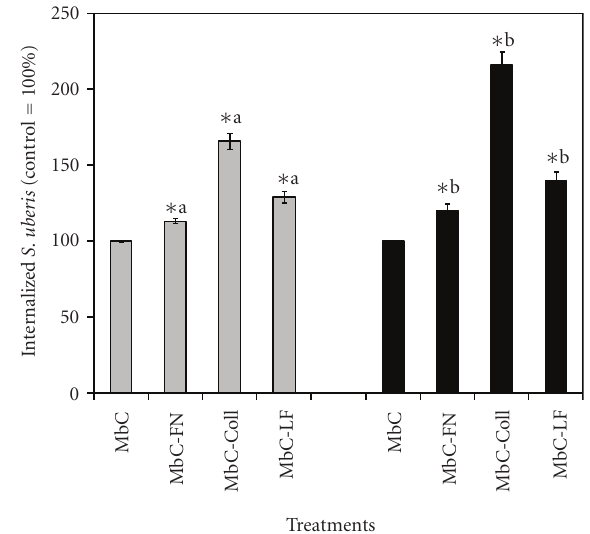
Figure 2: E ff ect of treatment with host proteins on receptor- mediated internalization of Streptococcus uberis into bovine mam- mary epithelial cells. Fibronectin (FN), collagen (Coll), and bovine lactoferrin (LF), pretreated S. uberis UT888 ( ) and UT366 ( ) were cocultured with bovine mammary epithelial cells treated with the caveolae-mediated endocytosis inhibitor Methyl- β − cyclodextran (M β C) and colony forming units per ml (cfu/mL) of intracellular S. uberis calculated. Data are presented as the percentage of untreated controls (100%; UT888 = 7.5 × 10 2 ; UT366 = 3.0 × 10 2 ) and bars represent the standard error of the mean (SEM) of three independent experiments run in triplicate. ( ∗ ) indicates statistically significant di ff erences ( P < . 05) with the corresponding control. Means with similar superscript letters within each strain are statistically di ff erent ( P < .